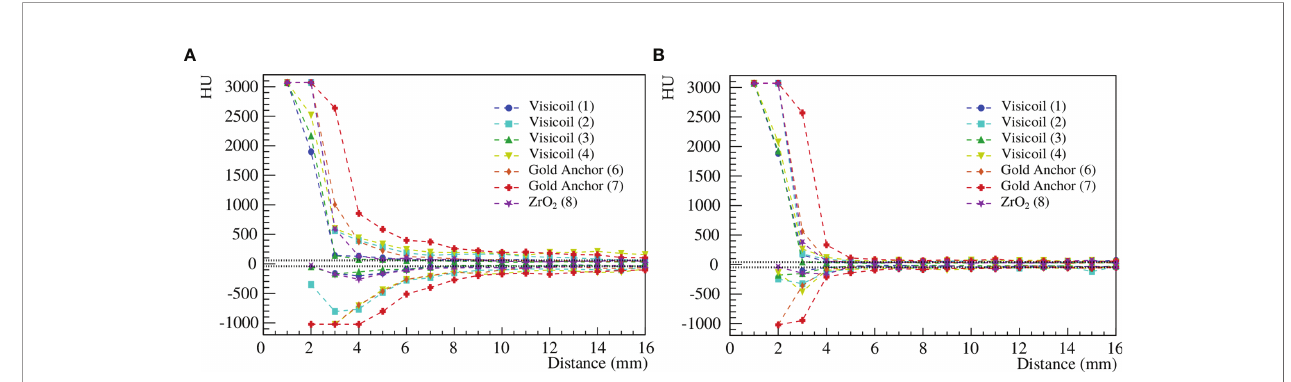
FIGURE 4 | Maximum and minimum HU as a function of the distance to the fi ducial marker for the conventional treatment planning CT (A) and with iMAR correction (B) for 7 fi ducial markers ( Table 1